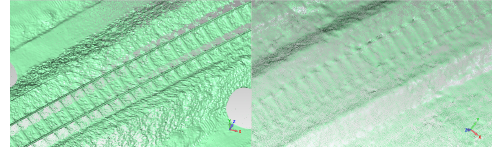
Figure 2: Differences in point spacing. Left: Laser point cloud, Right: Photogrammetric point cloud. Fig. 3 shows the proposed point cloud registration approach that pro- ceeds in steps, rather than solving for all transformation parameters at once. It is inspired by the way a hu- man operator interactively performs this task: since the operator has to work with a 2D view of the point cloud, he first rotates and translates the point clouds to get a similar per- spective for both in which he can see similar shapes or features (e.g. a birds-eye view), then adjusts the re- maining parameters (translation, in- plane rotation, scale), and finally re- fines the registration. Figure 3: Registration workflow The proposed registration algorithm